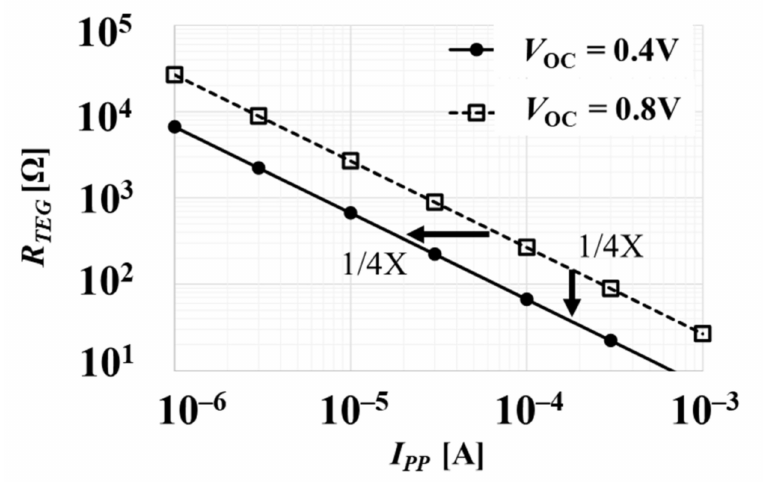
Figure 7. R TEG vs. I PP with V OC = 0.4 V, 0.8 V, η = 0.5, V PP = 3